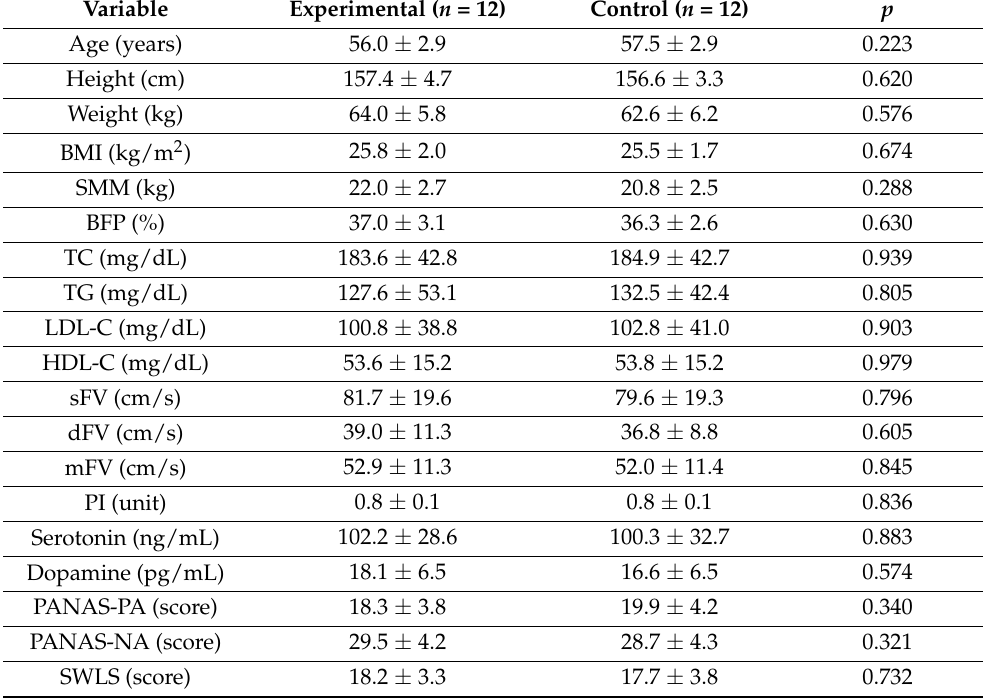
Table 1. Characteristics of the participants.